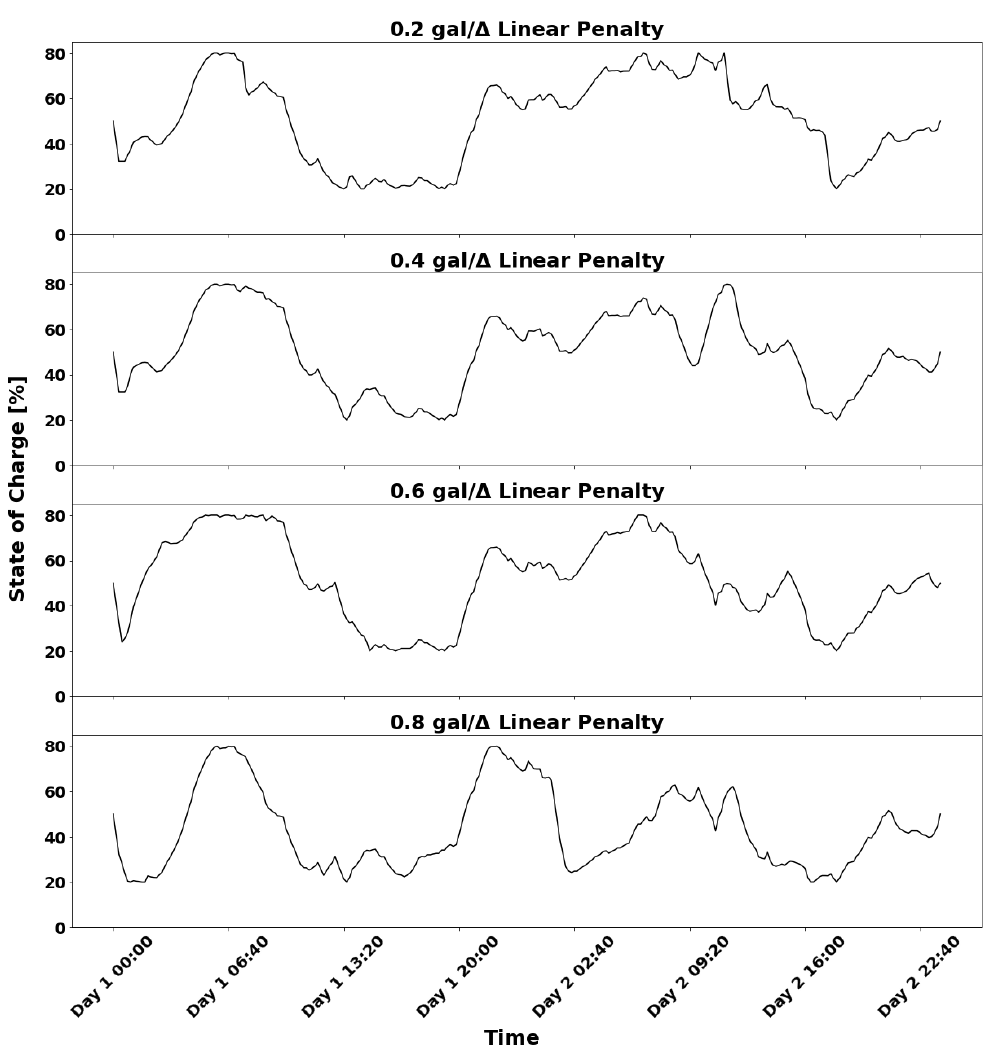
Figure 8. Battery state of charge for the instances shown in Figure